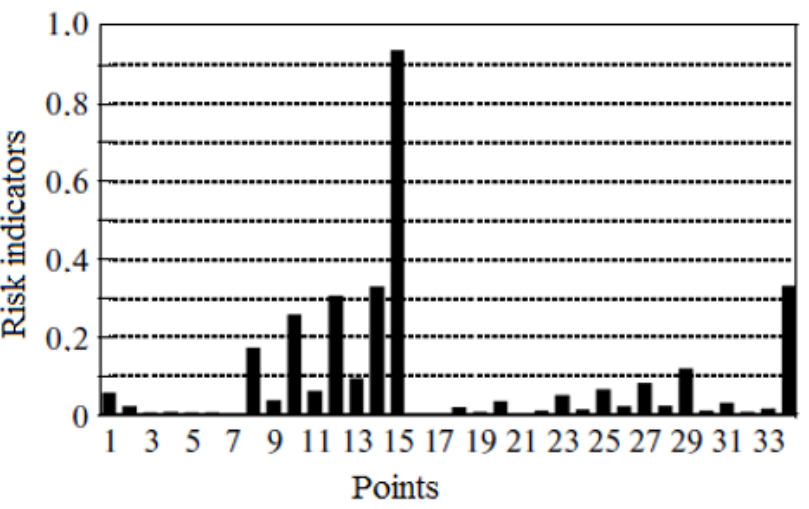
Figure 14. The diagram of risk metrics for the initial network.